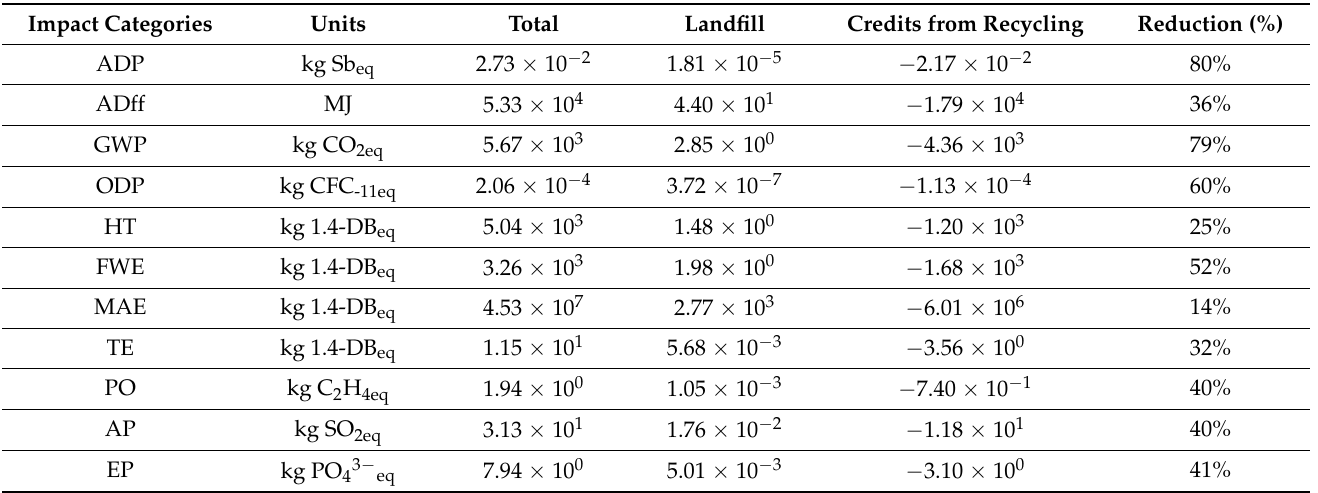
Table 3. Total impacts and credits of the EOL.